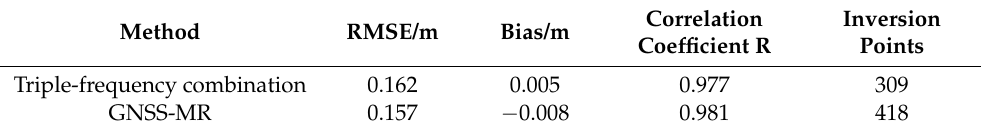
Table 1. A comparison table of the inversion results. Method RMSE/m